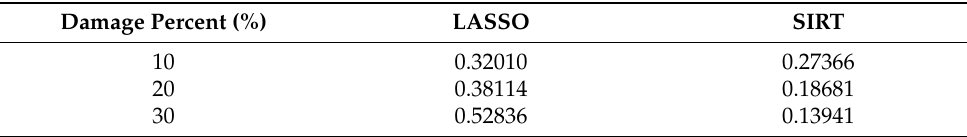
Table 1. Normalized errors of the